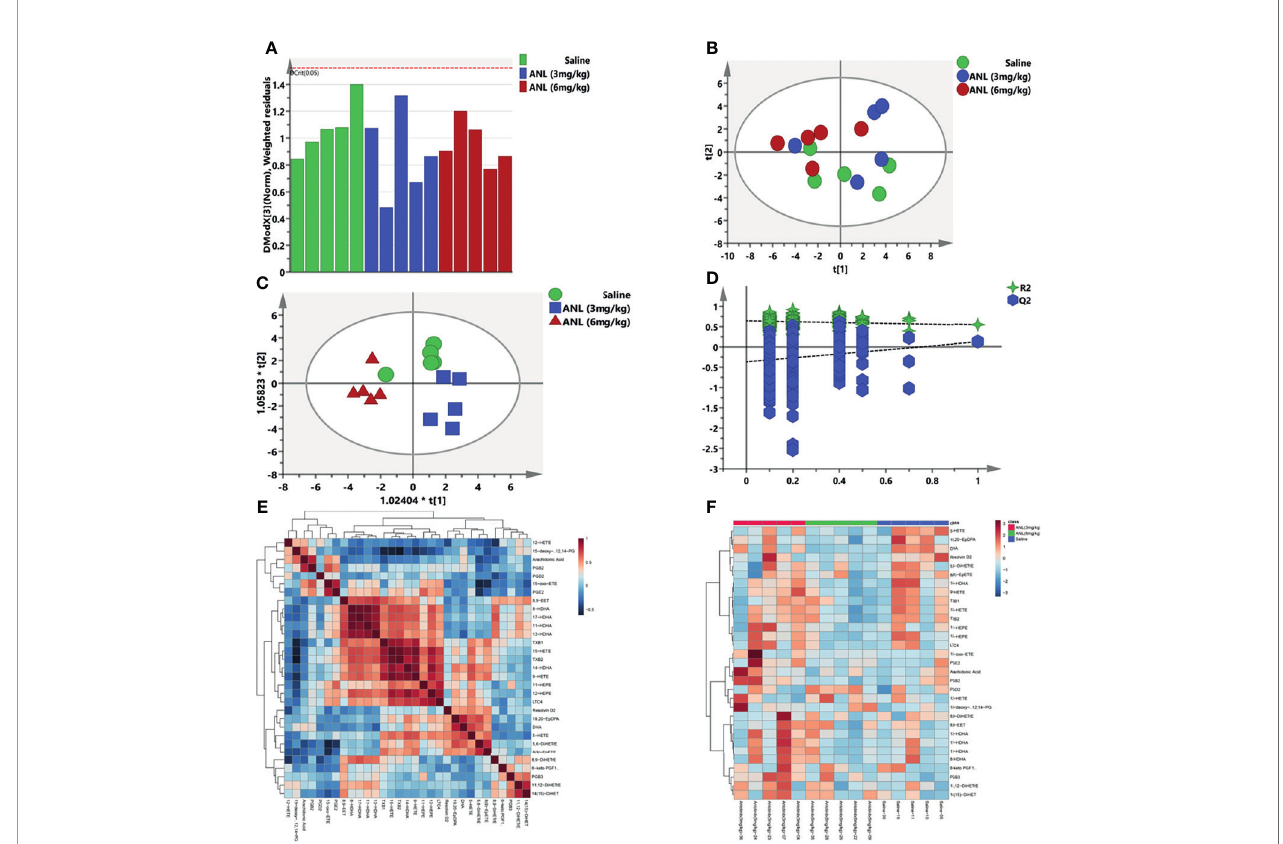
FIGURE 4 | The eicosanoid metabolomic pro fi les of anlotinib. (A) DModX curve. (B) PCA. (C) OPLS-DA. (D) Permutation test with 200 iterations. (E) Differential metabolite correlation heatmaps. (F) HCA of eicosanoid metabolomic pro fi ling.